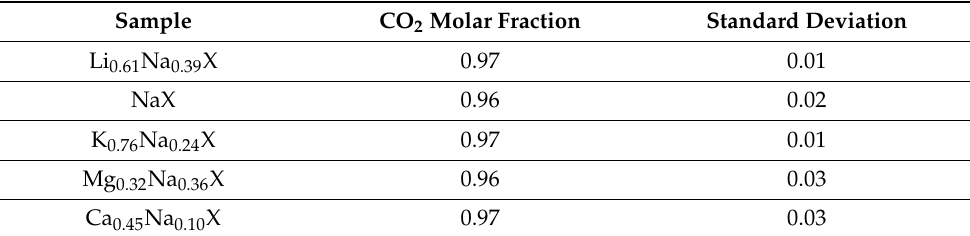
Table 9. Selectivity of the